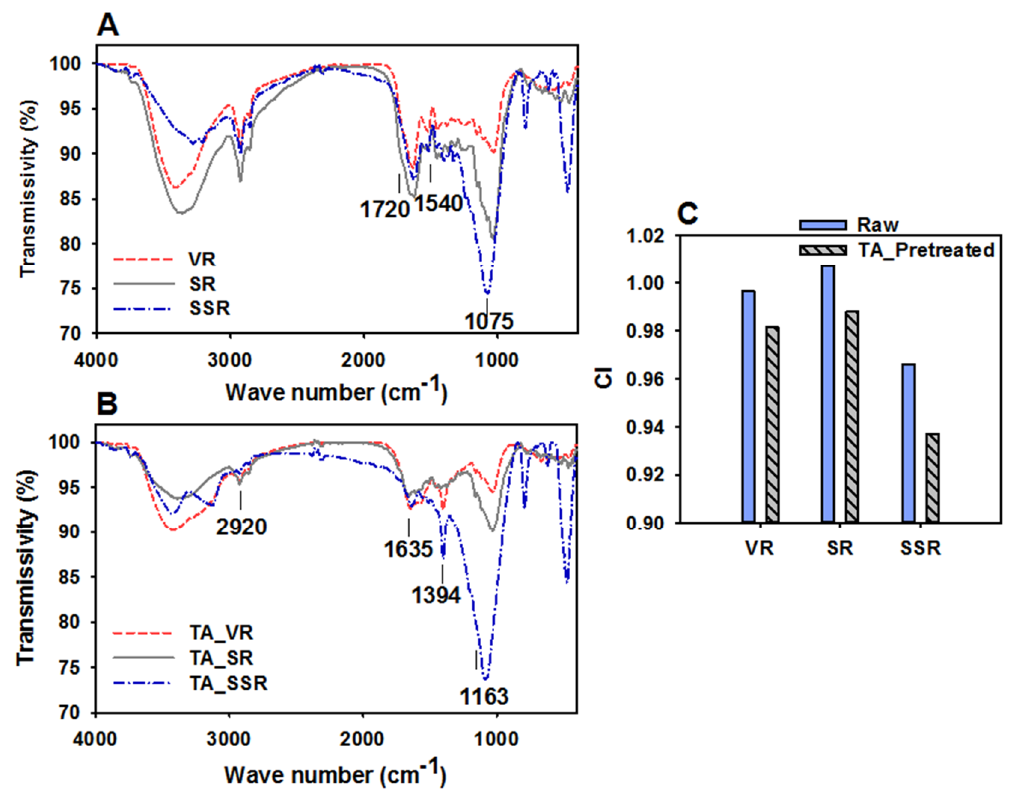
Figure 1. FTIR spectra and crystallinity indexes (CI) of the three PWs, ( A ) for raw PWs, ( B )for pretreated PWs , ( C ) for CI of the raw and pretreated PWs.